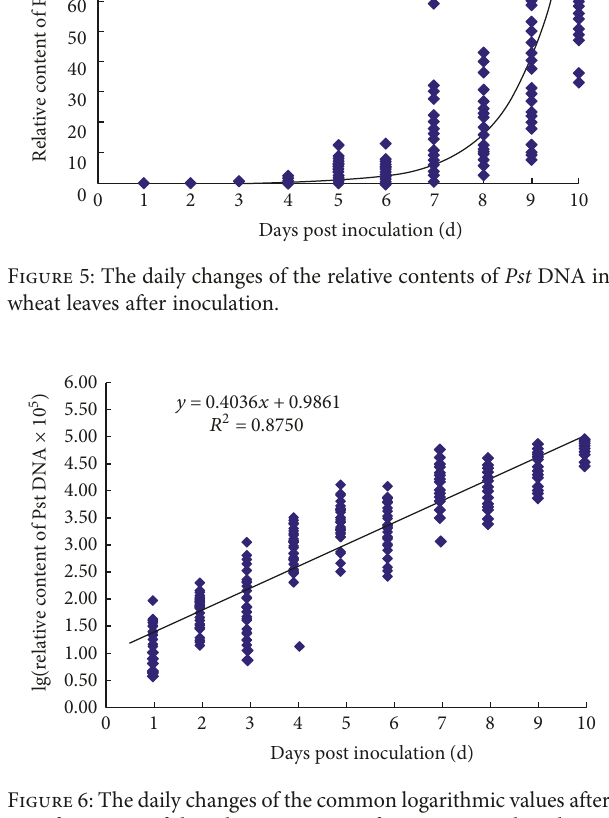
Figure 6: The daily changes of the common logarithmic values after transformation of the relative contents of Pst DNA in wheat leaves after